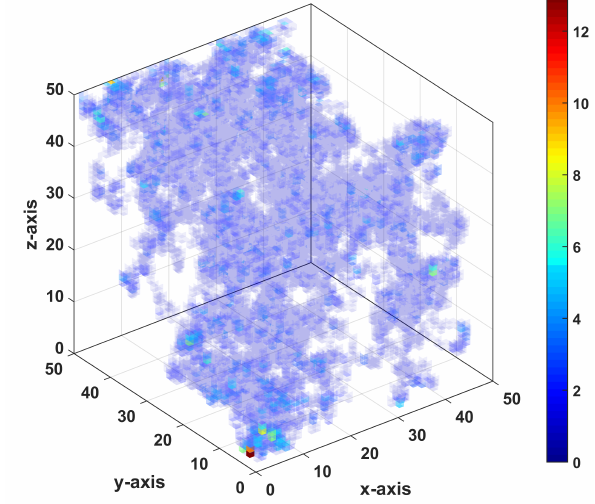
Figure 13. Color-coded simulation for the visits in each cell, for 10,000 iterations.